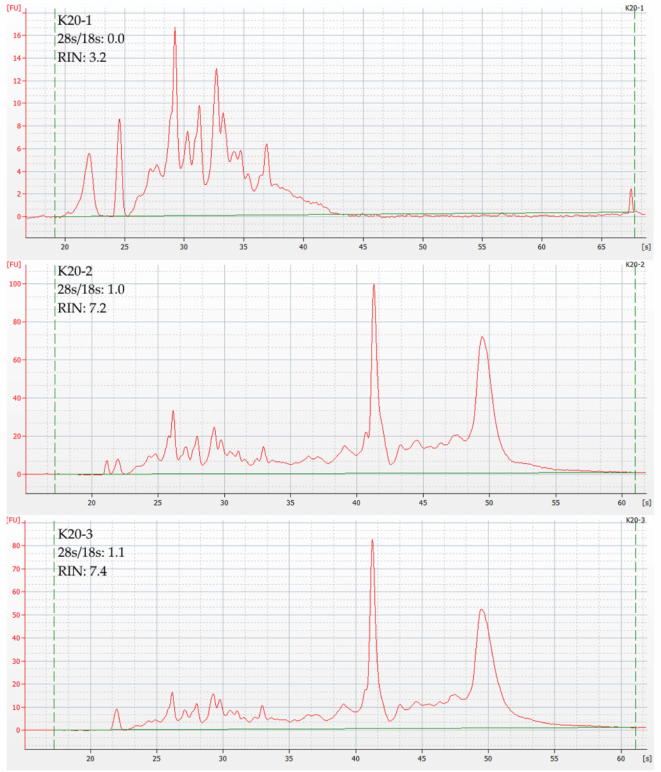
Figure 2. Graphical visualization of capillary electrophoresis results for derived cartilage samples K_20_12_25_03. Y-axis represents fluorescence intensity; X-axis represents time in seconds. Horizontal green line represents the fluorescence threshold; vertical dotted green lines mark the analyzed time